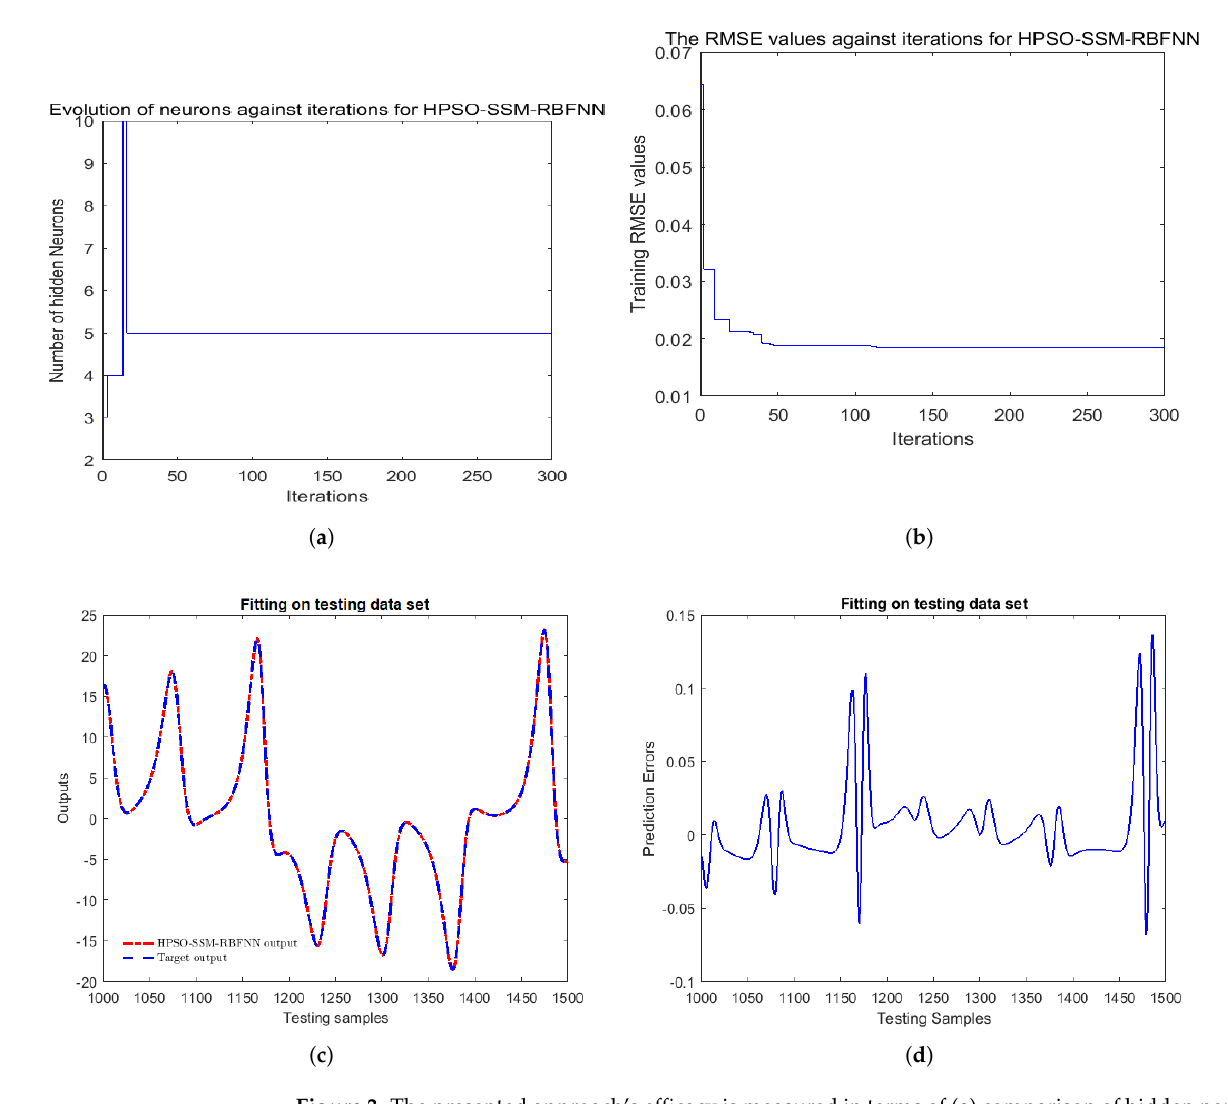
Figure 3. The presented approach’s efficacy is measured in terms of ( a ) comparison of hidden neurons for the training of proposed and other conventional algorithms, ( b ) RMSE values during the training phase, ( c ) predicted outcomes of HPSO-SSM-RBFNN during the testing phase, ( d ) the prediction errors during the testing